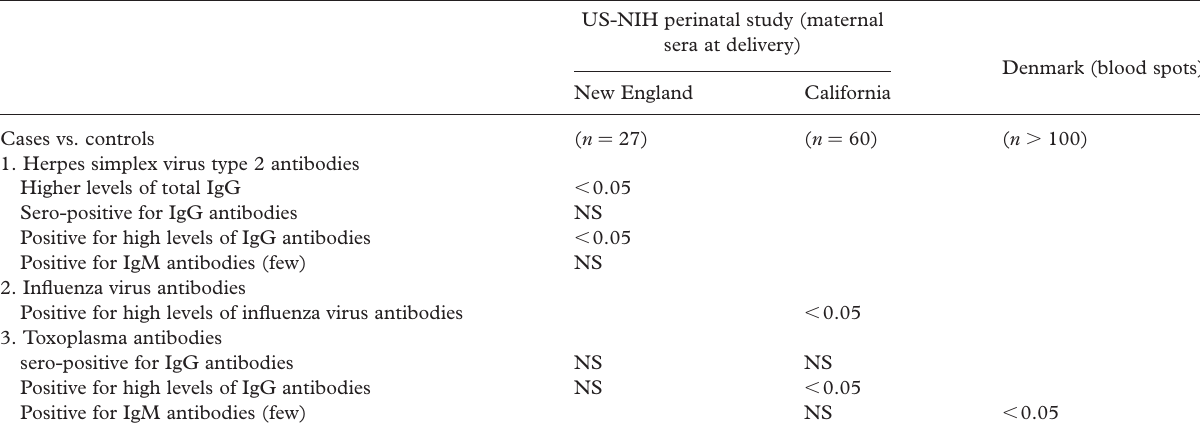
US-NIH perinatal study (maternal sera at delivery) Denmark (blood spots) New England California